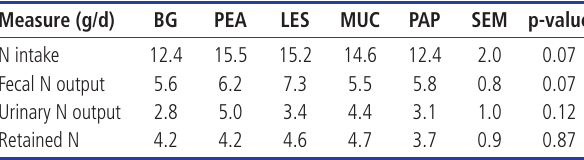
Table 4. Effects on nitrogen (N) balance in goats resulting from supplementing bahiagrass (BG) hay with perennial peanut (PEA), lespedeza (LES) hay, mucuna (MUC), or papaya seeds (PAP)